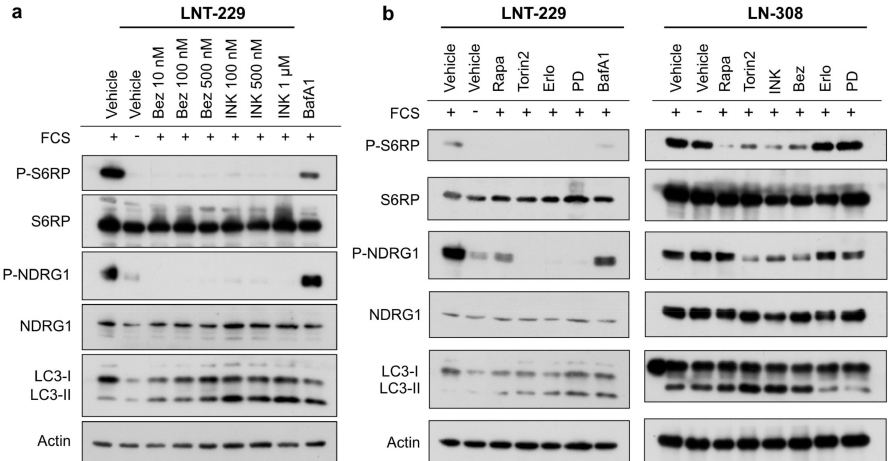
Figure 1. ATP-competitive mammalian target of rapamycin (mTOR) inhibitors e ff ectively inhibit mTOR complex 1 (mTORC1) and 2 (mTORC2) signal transduction. ( a ) LNT-229 cells were treated with INK-128, NVP-Bez235 or bafilomycin A1 (BafA1) (10 nM) as depicted in medium containing 10% fetal calf serum (FCS) for 2 h. Cell lysates were analyzed by immunoblot for phosphorylated (P) and total mTORC1 target protein S6RP and mTORC2 target protein NDRG1. ( b ) LNT-229 and LN-308 cells were treated for 2 h with rapamycin (100 nM), torin2 (100 nM), INK-128 (100 nM), NVP-Bez235 (10 nM), erlotinib (10 µ M), PD153035 (10 µ M) or bafilomycin A1 (BafA1) (10 nM) in FCS-free medium or medium containing 10% FCS as